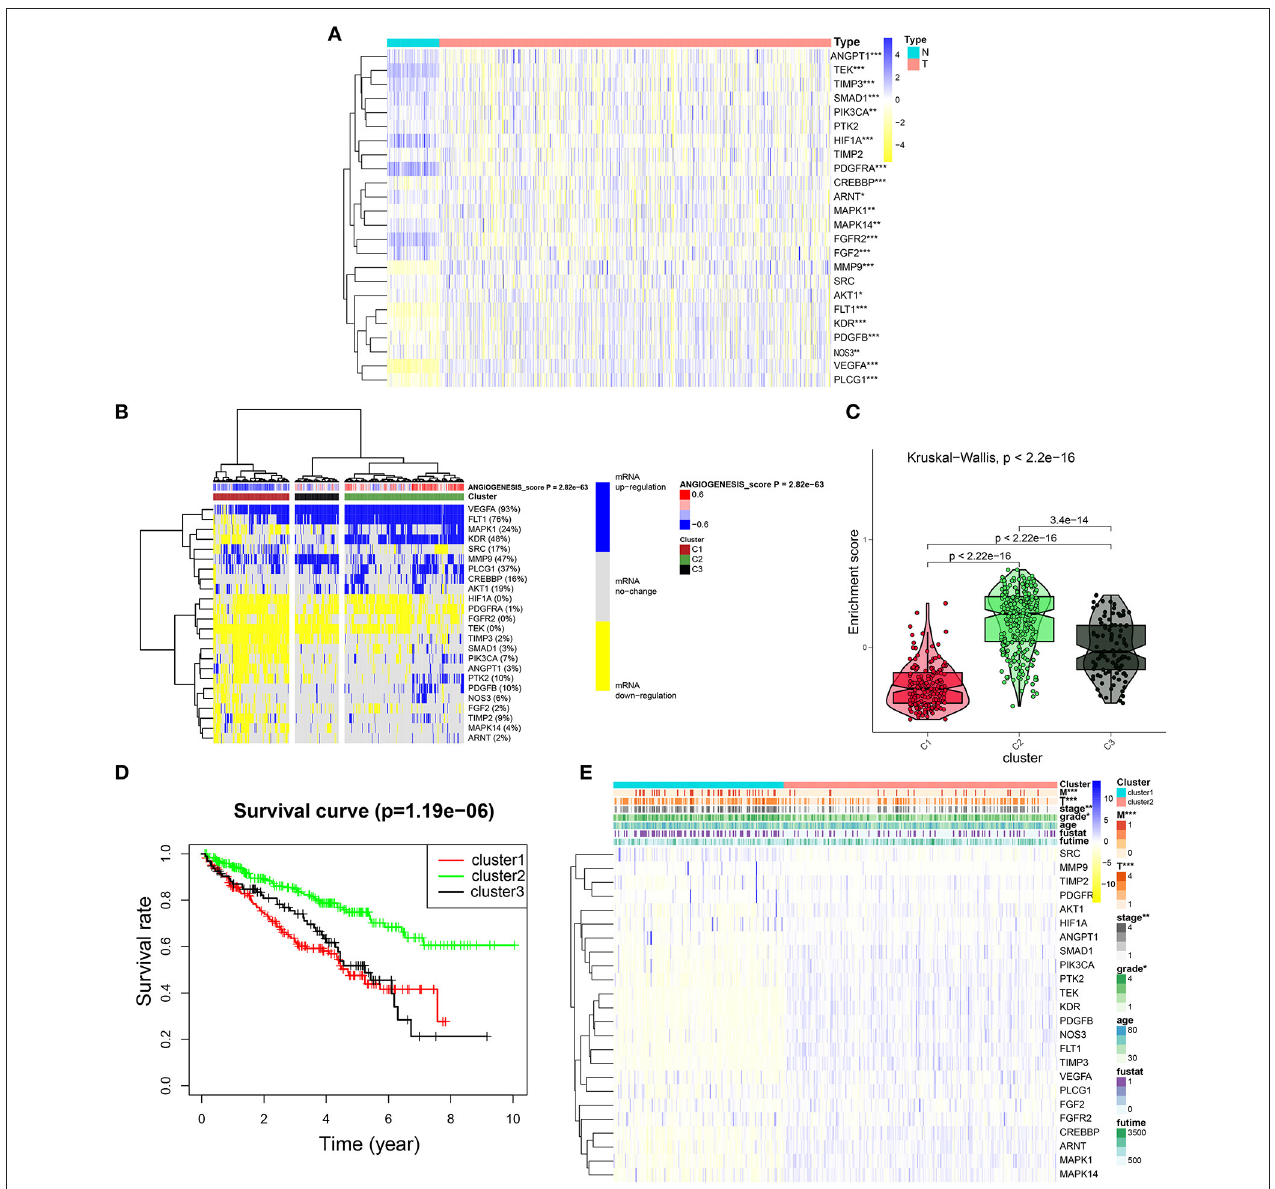
FIGURE 4 | Cluster analysis based on the angiogenesis scores. (A) The heat map showed the expression levels of most of these genes were significantly different between the tumor tissues and normal tissues. In the color bar on the right side, blue represents gene up-regulation and yellow represents gene down-regulation. N (green) represents the normal sample, T (red) represents the tumor sample (* p < 0.05, ** p < 0.01, *** p < 0.001). (B) Clustering of gene data from the TCGA database shows three clusters by the heat map: angiogenesis inactive (cluster 1 or C1), angiogenesis active (cluster 2 or C2), and normal angiogenesis (cluster 3 or C3). The percentage of patients whose genes are upregulated is given on the right side of the figure. In the color bar on the right side, blue represents mRNA upregulation, yellow represents mRNA downregulation, and gray represents mRNA no-regulation. The angiogenesis score is projected to four colors, negative values are displayed in blue, and positive values are displayed in red. (C) The violin plot drawn by the “ggpubr” package shows that the enrichment scores of the three clusters from high to low are cluster 2, cluster 3, and cluster 1. The statistical method used here is the “kruskal.test” and the p -values are displayed above the clusters. (D) The survival curve of the three clusters. The survival rate of cluster 2 is higher than cluster 1 and cluster 3. The red line represents cluster 1; the green line represents cluster 2; and the black line represents cluster 3. The abscissa represents the number of years and the ordinate represents the survival probability. (E) The heat map shows the correlation between the two clusters and the clinicopathological features. In the color bar on the right side, blue represents gene upregulation, and yellow represents gene downregulation (* p < 0.05, ** p < 0.01, and *** p < 0.001).